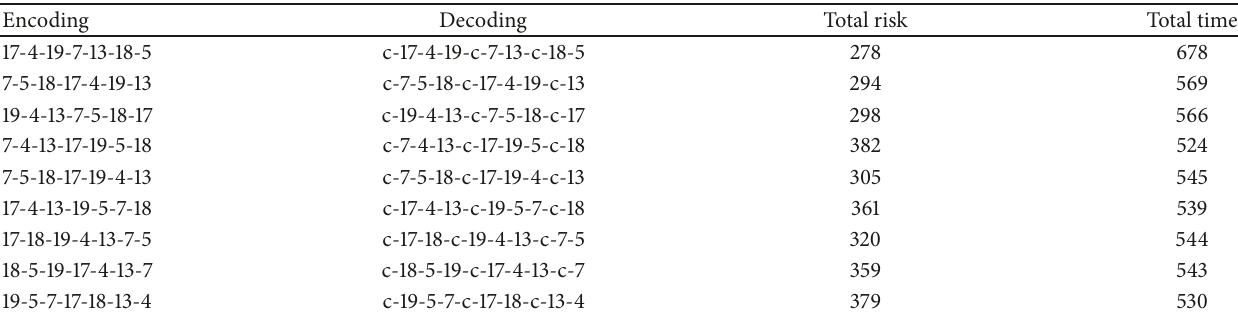
Table 11: Pareto solution set of robust control parameters Γ =0 for distribution center c. Encoding